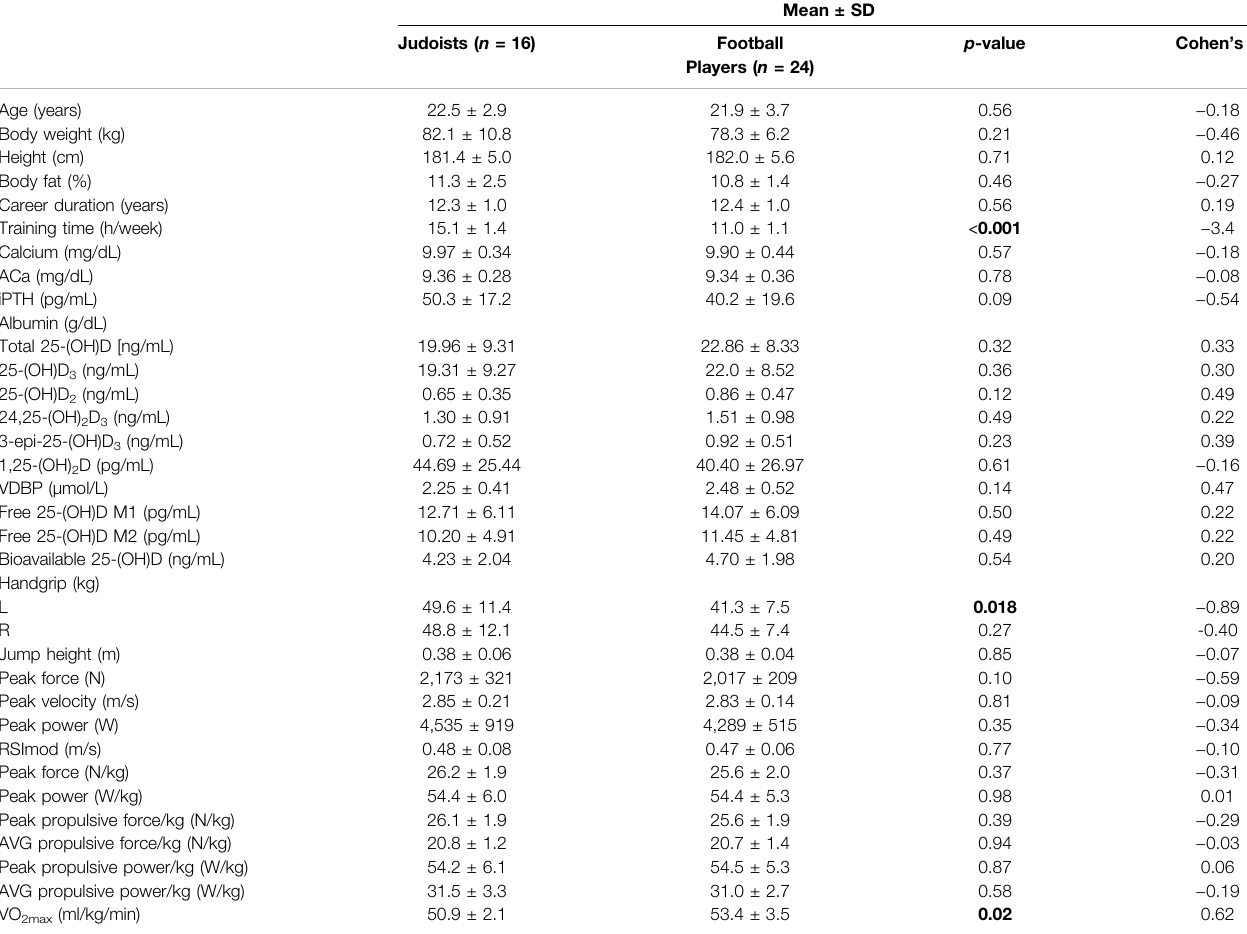
TABLE 1 | Athletes ’ characteristic and physical performance